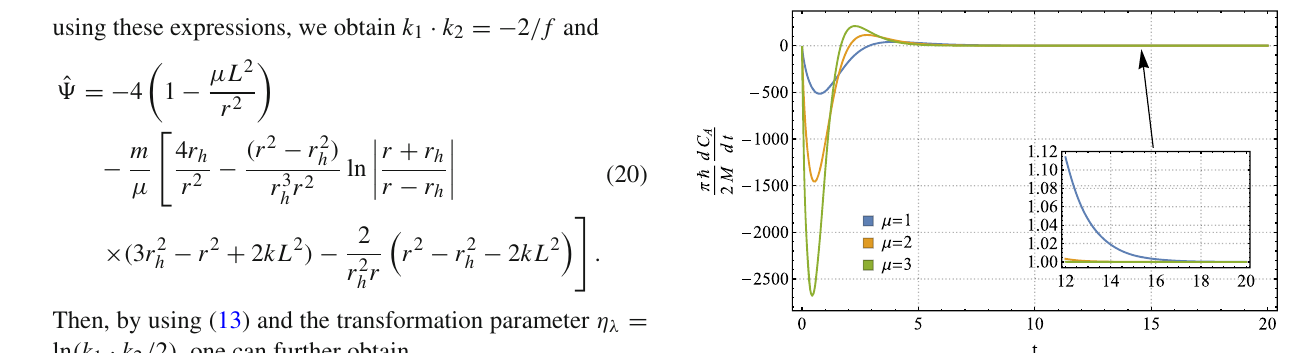
Fig. 2 The CA complexity growth rate for the planer case, where we set k = 0 , l ct = 1 , L = 1 and m = 0 . 01